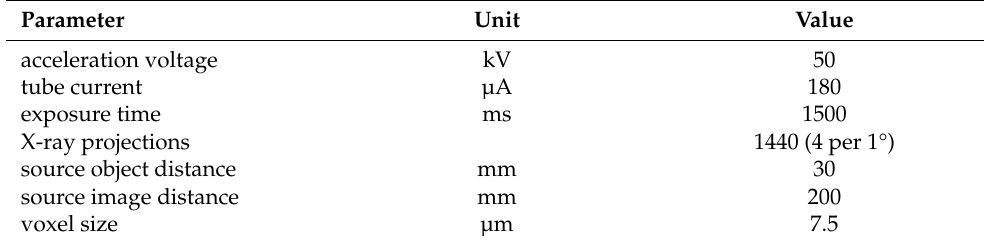
Table 3. Test specification for CT analysis of deformation specimens.